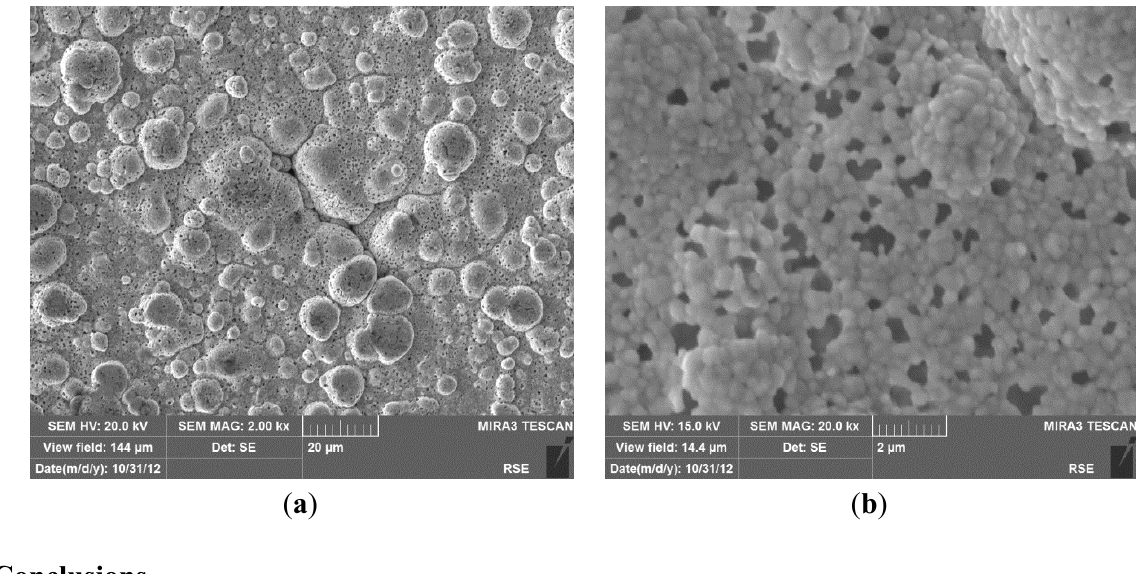
Figure 9. SEM images with secondary electrons of the Pd/PSS membrane surface at the end of the tests. ( a ) Typical morphology of Pd-clusters; ( b ) Presence of pinholes on the